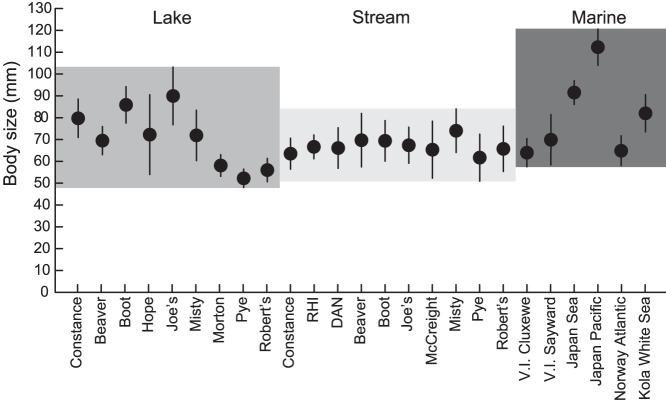
Body size at reproduction in the global stickleback populations from lake, stream, and marine habitats.Samples from the Lake Constance basin are pooled for each habitat type (further details on the samples are given in the text). Error bars are one standard deviation in each direction. The shaded boxes behind the symbols indicate the body size range spanned by the standard deviations in each habitat. Note the low variance in population mean size among the stream populations as compared to lake and marine fish.